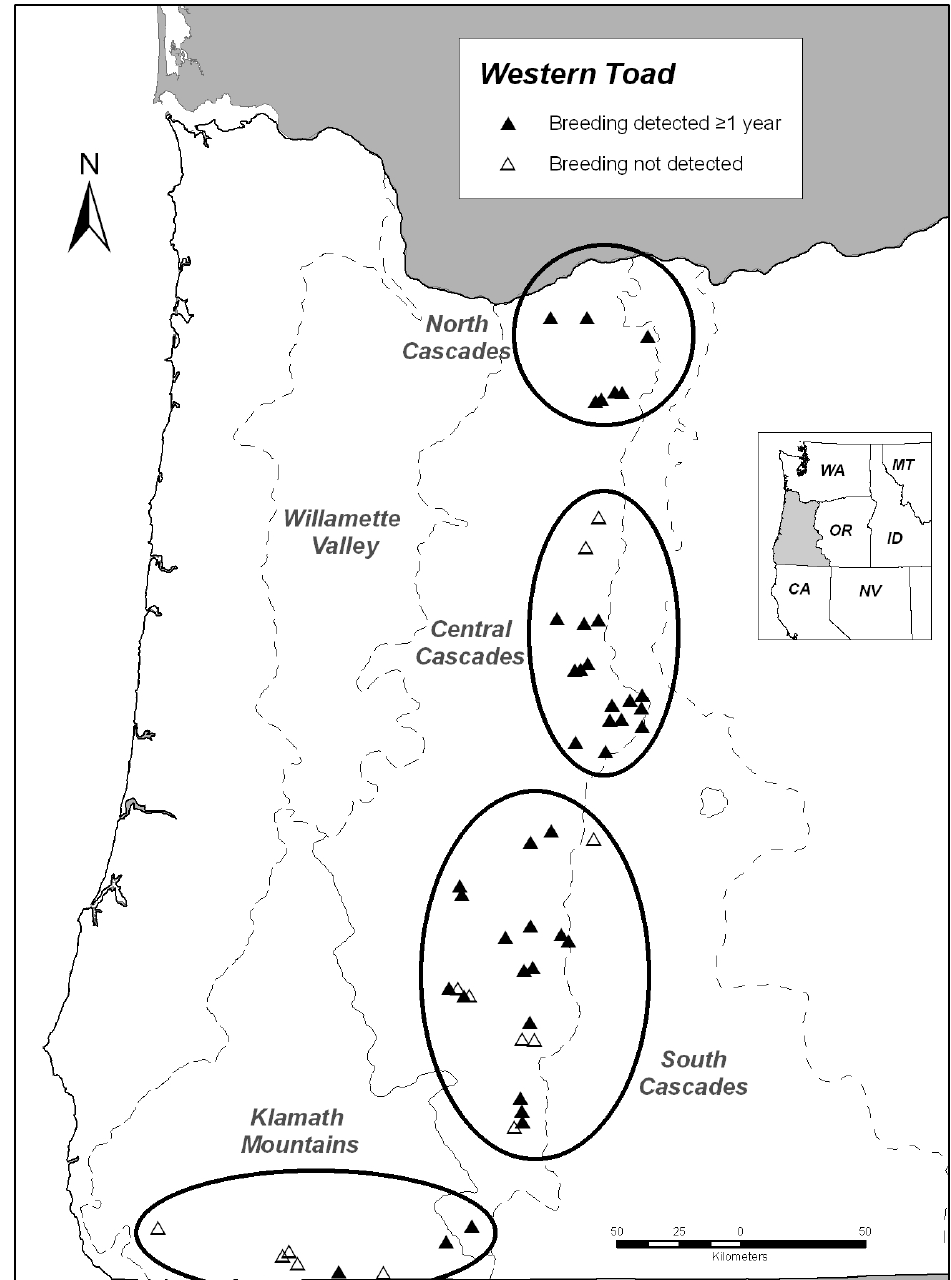
Figure 1. Historical breeding sites (N = 54) surveyed for B. boreas in 2001-2004, Cascade Range, Oregon,